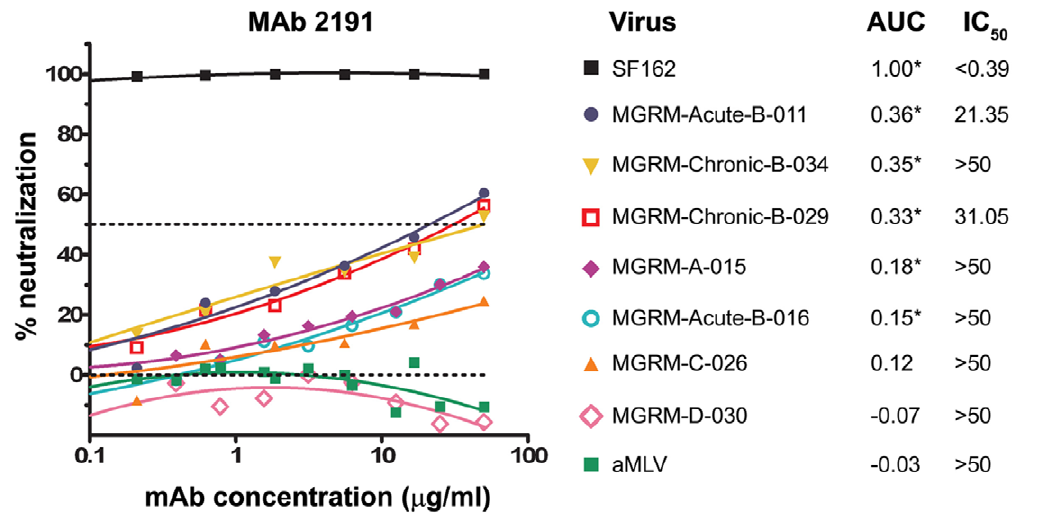
Figure 1. The neutralization of nine HIV-1 pseudoviruses by mAb 2191 using U87 as target cells. The neutralization curves of anti-V3 mAb 2191 against nine selected HIV-1 pseudoviruses are shown with their corresponding AUC and IC 50 values. Fifty percent neutralization is denoted by the dashed line. Significant neutralization at the confidence level of p , 0.001 (denoted with * after AUC values) was determined statistically based on comparison with the AUC values of the negative controls together with the slopes of the titration curves as described in Materials and Methods. For viruses coming from patients where the date of infection is known, viruses are denoted as coming from acutely- or chronically-infected patients, and the clade of the virus is denoted by the capital letter in its name (A, B, C or